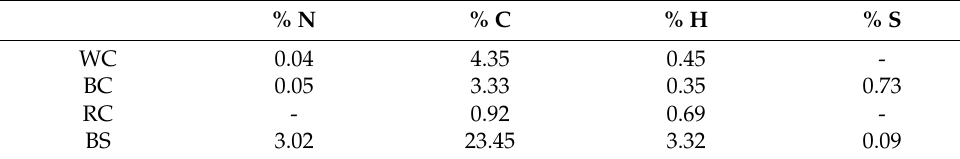
Table 2. Elementary CNH-S analysis of clay materials and wastewater sludge.